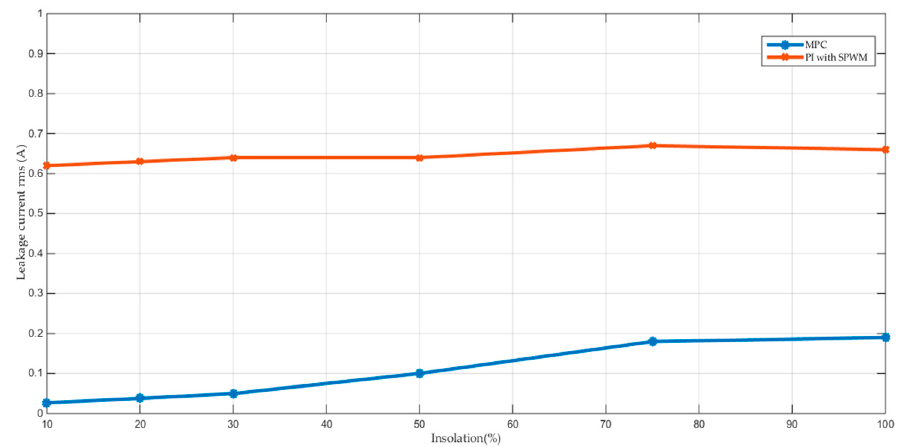
Figure 9. Variation of the leakage current with the insolation level for the MPC controller and PI current controller with SPW modulation.